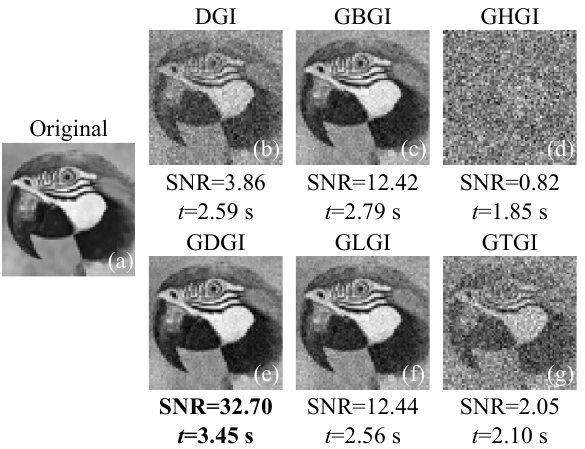
Figure 3. Simulation results of the grayscale image labelled “02” using different algorithms with m = 20,480 measurements. ( a ) is the original image “02”, ( b – g ) are the images retrieved by the DGI, GBGI, GHGI, GDGI, GLGI and GTGI,